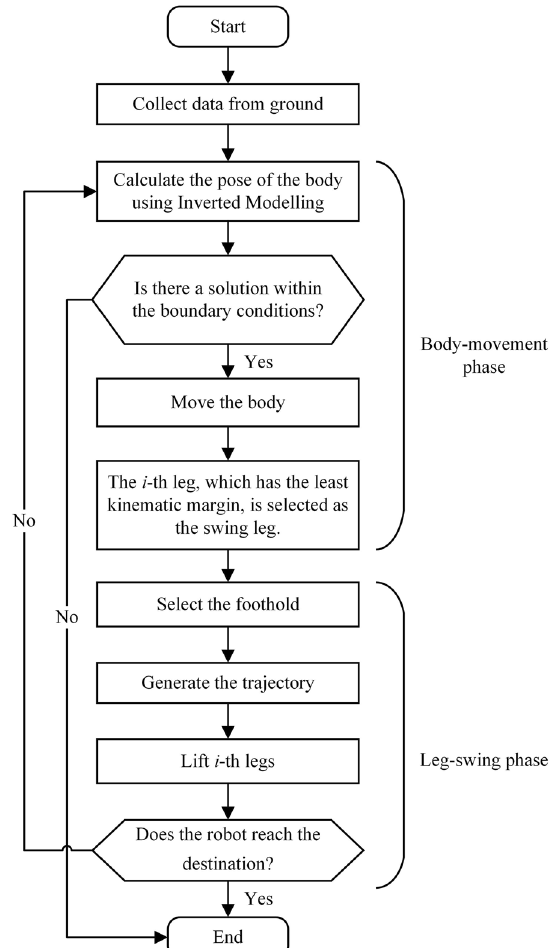
Figure 9 Flowchart for proposed gait algorithm using Inverted